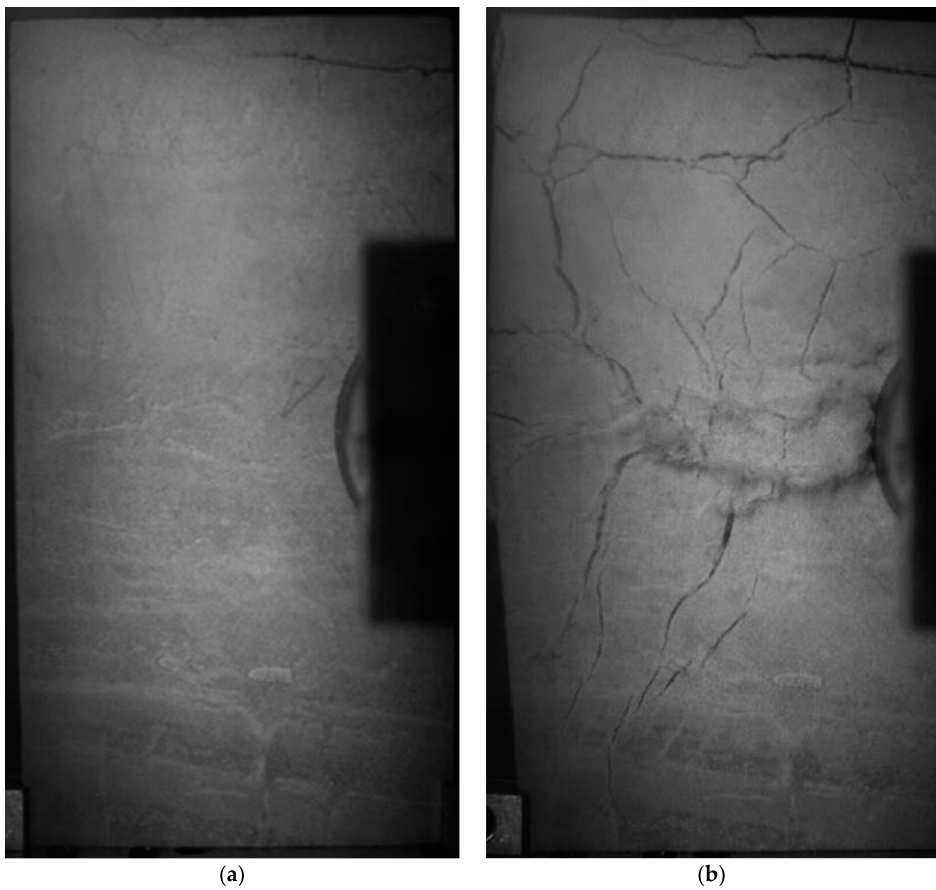
Figure 9. EOI test in the sarcophagus configuration ( 𝑣 = 147m s⁄ ). Pictures of ultra-high-speed camera: ( a ) prior fragmentation and ( b ) after fragmentation.